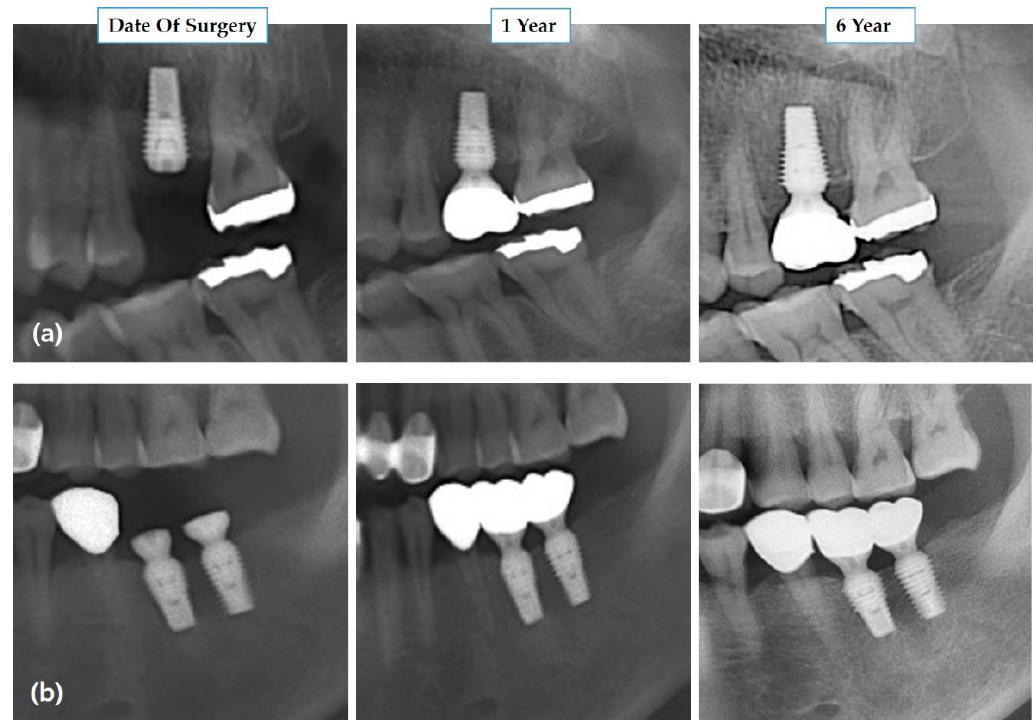
Figure 3. Radiologic evaluation of the wide diameter implant in two different patients. ( a ) Implant placement in the left maxillary posterior region on the day of implant placement, one year and six years after prosthetic loading. ( b ) Implant placement in the left mandibular posterior region on the day of implant placement, one year and six years after prosthetic loading.